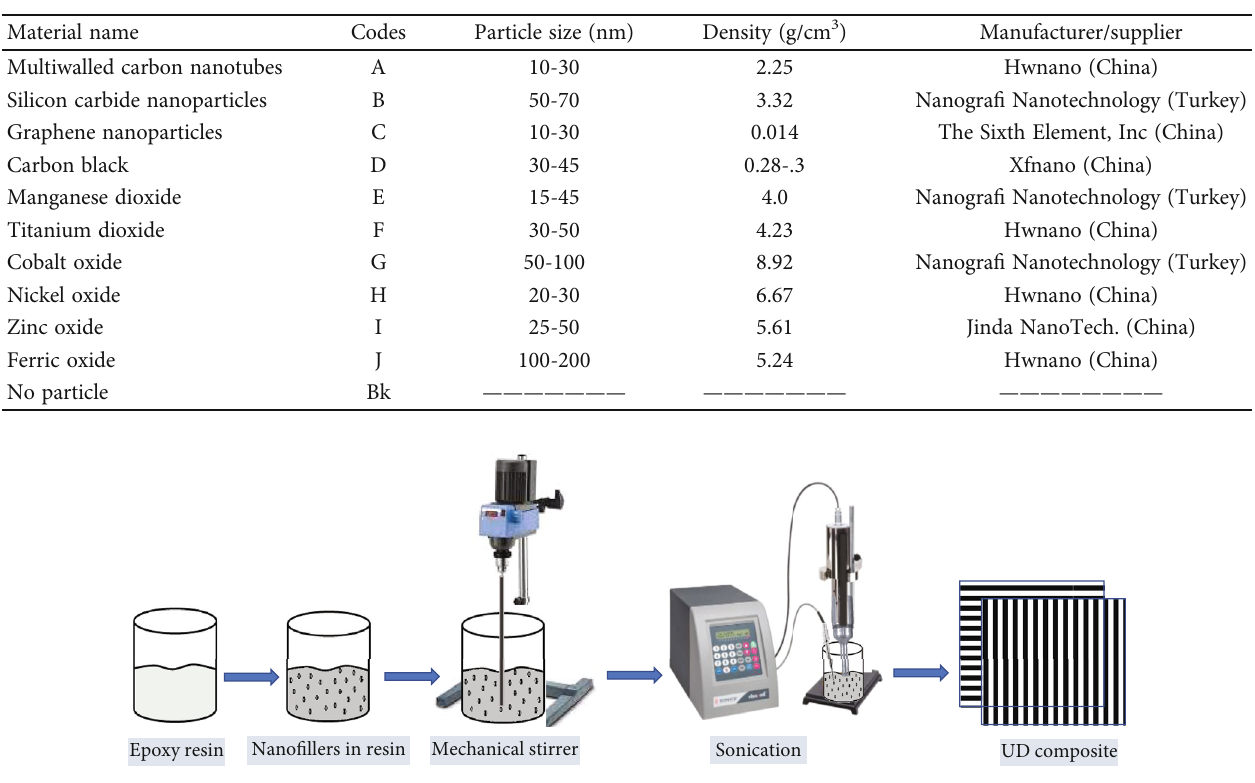
Figure 1: Schematic diagram of dispersion